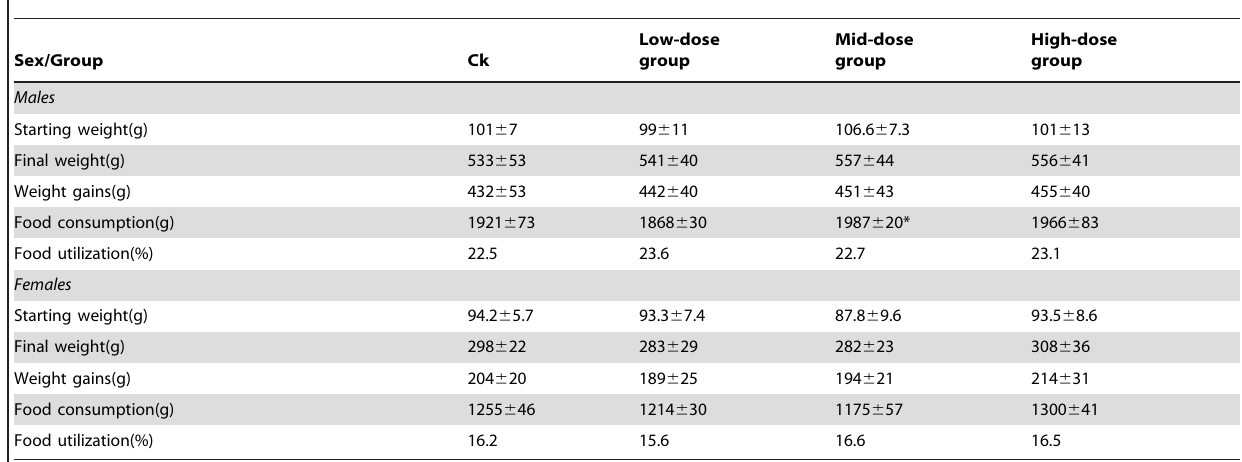
Table 6. Food consumption and body weight of 90-day feeding.